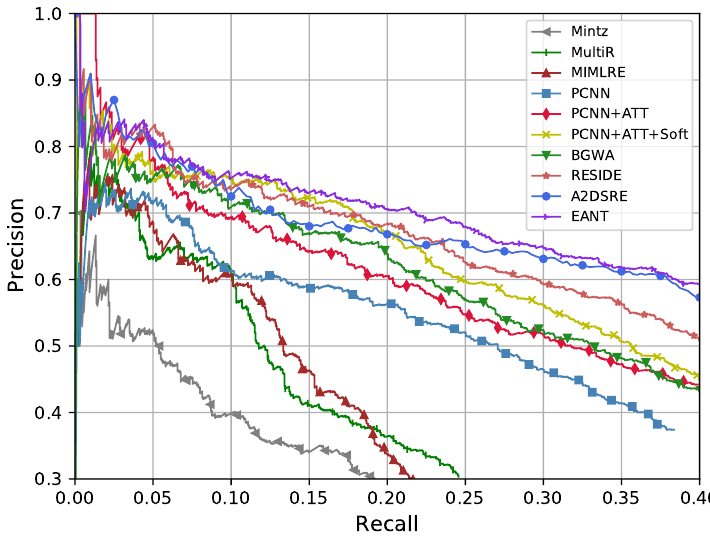
Figure 3. Precision-recall curves of EANT and